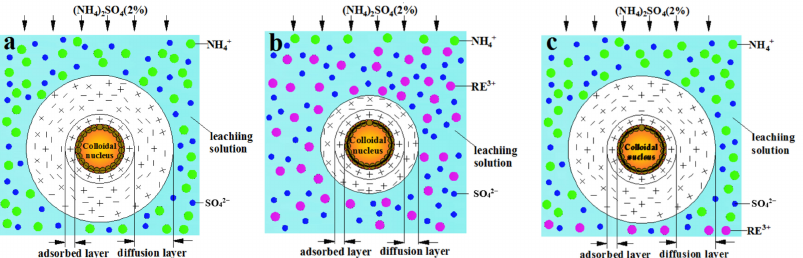
labeled from 353 to 359; ( b ) chemical compositions of microparticles.